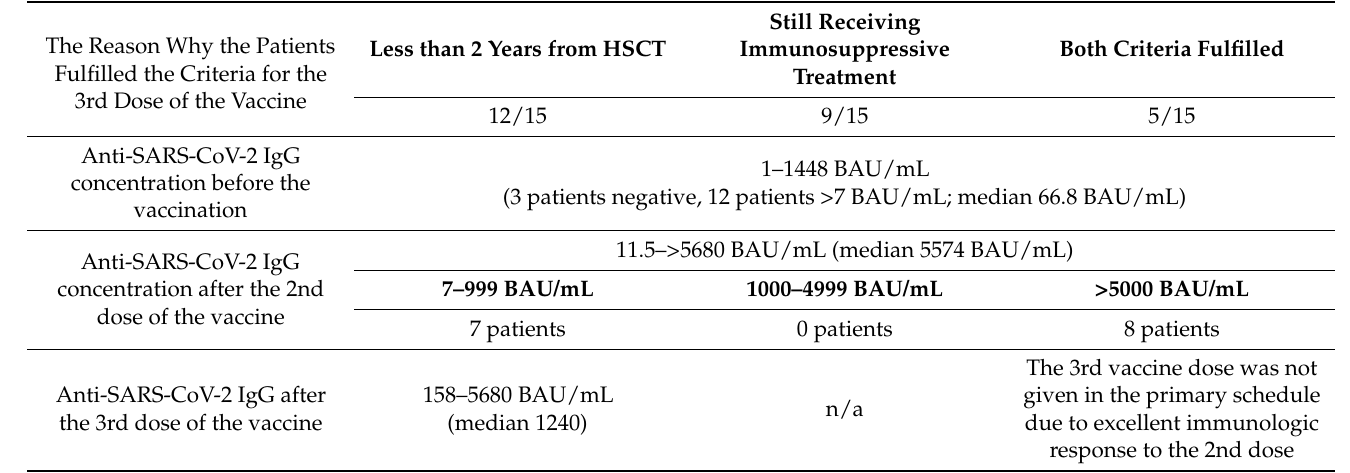
Table 4. The subgroup of HSCT patients who fulfilled the official criteria for the three-dose primary COVID-19 vaccine